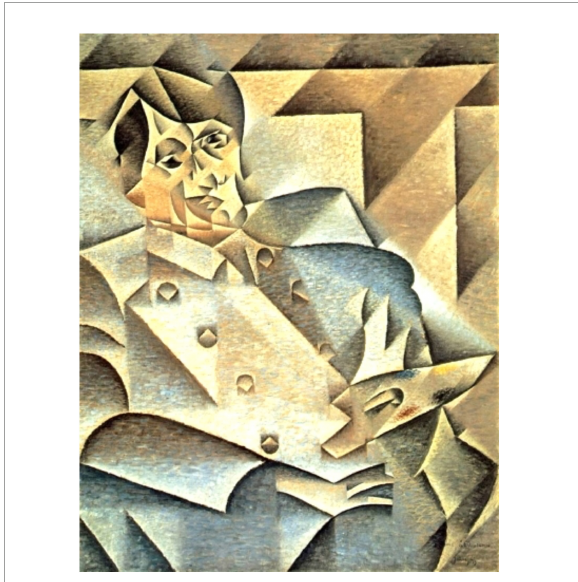
FIGURE6 Cubistic image of artwork Portrait of Pablo Picasso , Juan Gris (1912) Copyright information: Shown works are in the public domain in its country of origin and other countries and areas where the copyright term is the author’s life plus 70 years or fewer. These works are in the public domain in the United States because it was published (or registered with the United States Copyright Office) before January 1, 1926 (for image search and copyrights: https://commons.wikimedia.org/wiki/File: